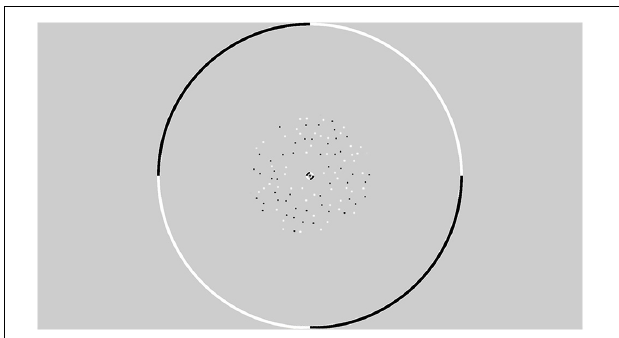
FIGURE 2 | An example from a single frame of the random dot stereogram pattern that is presented within a circular fixation lock. The dots are presented in an annulus with an inner radius of 1 ◦ and an outer radius of 6 ◦